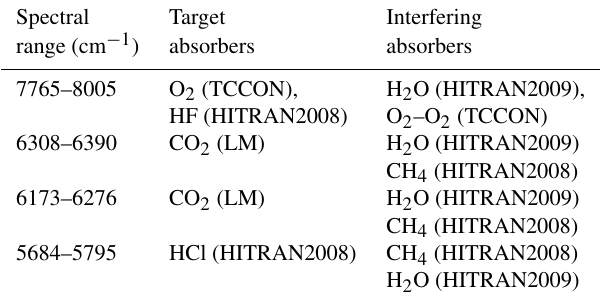
Table 1. Spectral retrieval windows and their properties used for processing the FTS absorption spectra in the SWIR. Parenthe- ses following absorber molecules indicate the used spectroscopic databases: TCCON refers to the spectroscopic database used by the Total Carbon Column Observing Network (Toon, 2014), HI- TRAN2008 refers to Rothman et al. (2009), and HITRAN2009 refers to Rothman et al. (2009) with published updates and our own empirical modifications. LM refers to the line-mixing database by Lamouroux et al. (2010) used as a correction to